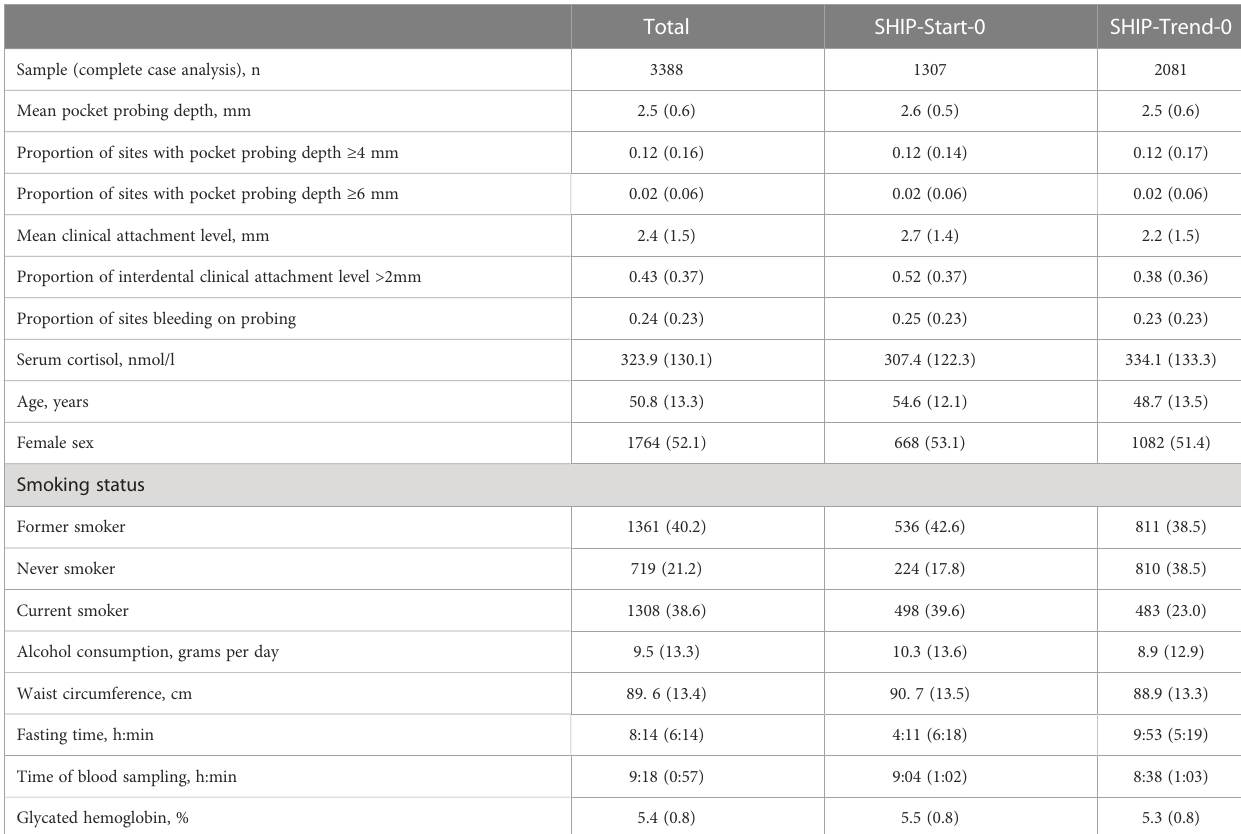
TABLE 1 Baseline descriptive statistics of the Study of Health in Pomerania